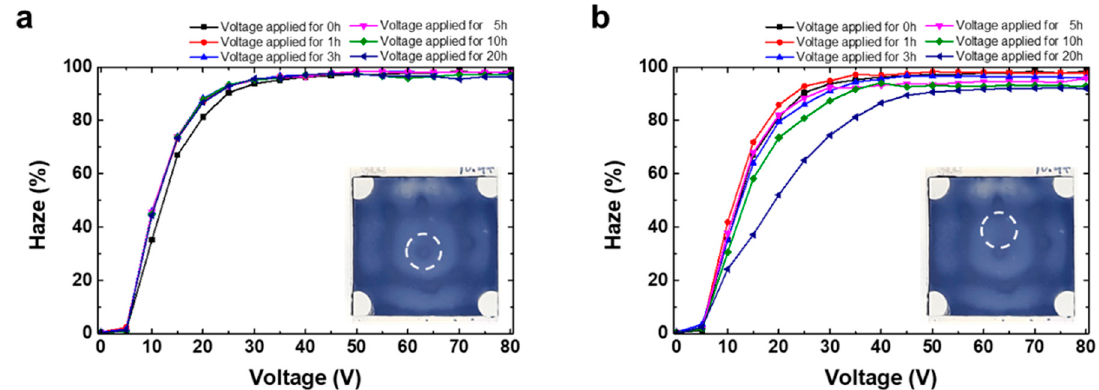
Figure 3. Measured haze of the ion-doped LC cell in the ( a ) dark and ( b ) bright regions as a function of operation time. The measurement points are marked as dotted circles in the photograph of the LC cell in the opaque state.